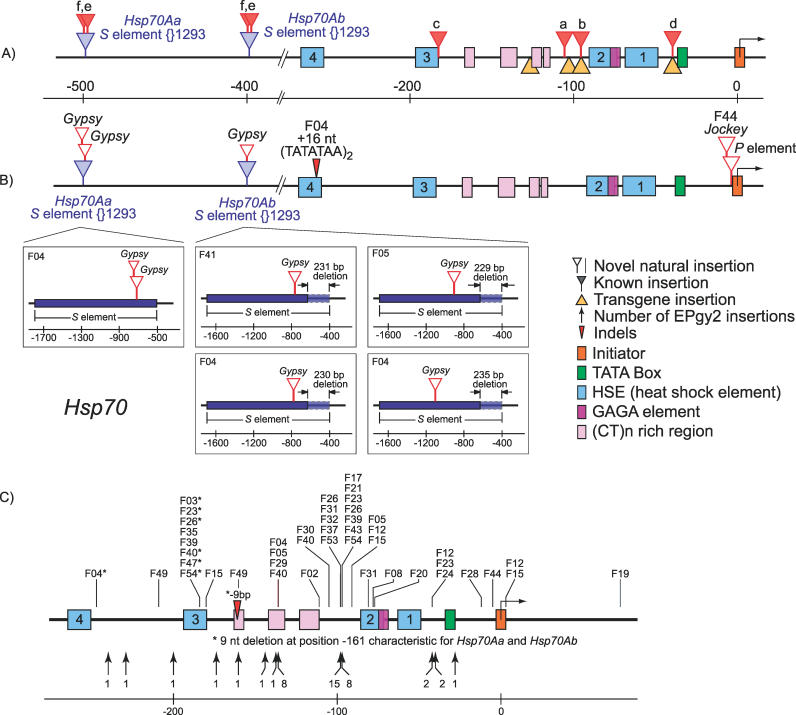
Locations of TEs Integrating into the Proximal Promoters of Hsp70 GenesSix nearly identical Hsp70 genes are present in the sequenced Drosophila genome, but only five copies in natural populations. The locations of selected promoter elements and sites are indicated for all copies.(A) Previously discovered TEs and experimental transpositions relative to the conserved Hsp70 sequence. a, Jockey element in Hsp70Ba [16]; b, c, and d, P elements in Hsp70Ba [14,15,21]. An S element is present between the oppositely oriented paralogs Hsp70Aa and Hsp70Bb [13], and is represented twice, corresponding to its location relative to each paralog, as are the HMS Beagle (e) [16] and “56H8” (f) [88] elements inserted within it. Triangles below the line indicate transgene insertion sites (FlyBase; http://flybase.bio.indiana.edu). (B) and (C) Bottom: newly discovered TEs, with the natural population in which they were discovered (F01–F54, exclusive of F06) indicated for each.(B) TEs other than P elements. Four are Gypsy elements that have integrated into the S element in specific populations, the fifth is a Gypsy that has inserted into a Gypsy, and the sixth is a Jockey that has inserted into a P element. The Gypsys are arbitrarily plotted relative to Hsp70Ab and Hsp70Aa, respectively.(C) Natural P elements in Hsp70. The arrows indicating the number of independent EPgy2 insertion sites recently described by Shilova et al. [10]. Except for the Gypsys, TEs were not mapped to a specific Hsp70 gene. Insertion sites localized within the Hsp70 region were all established by sequencing. For population codes, see Figure 1.